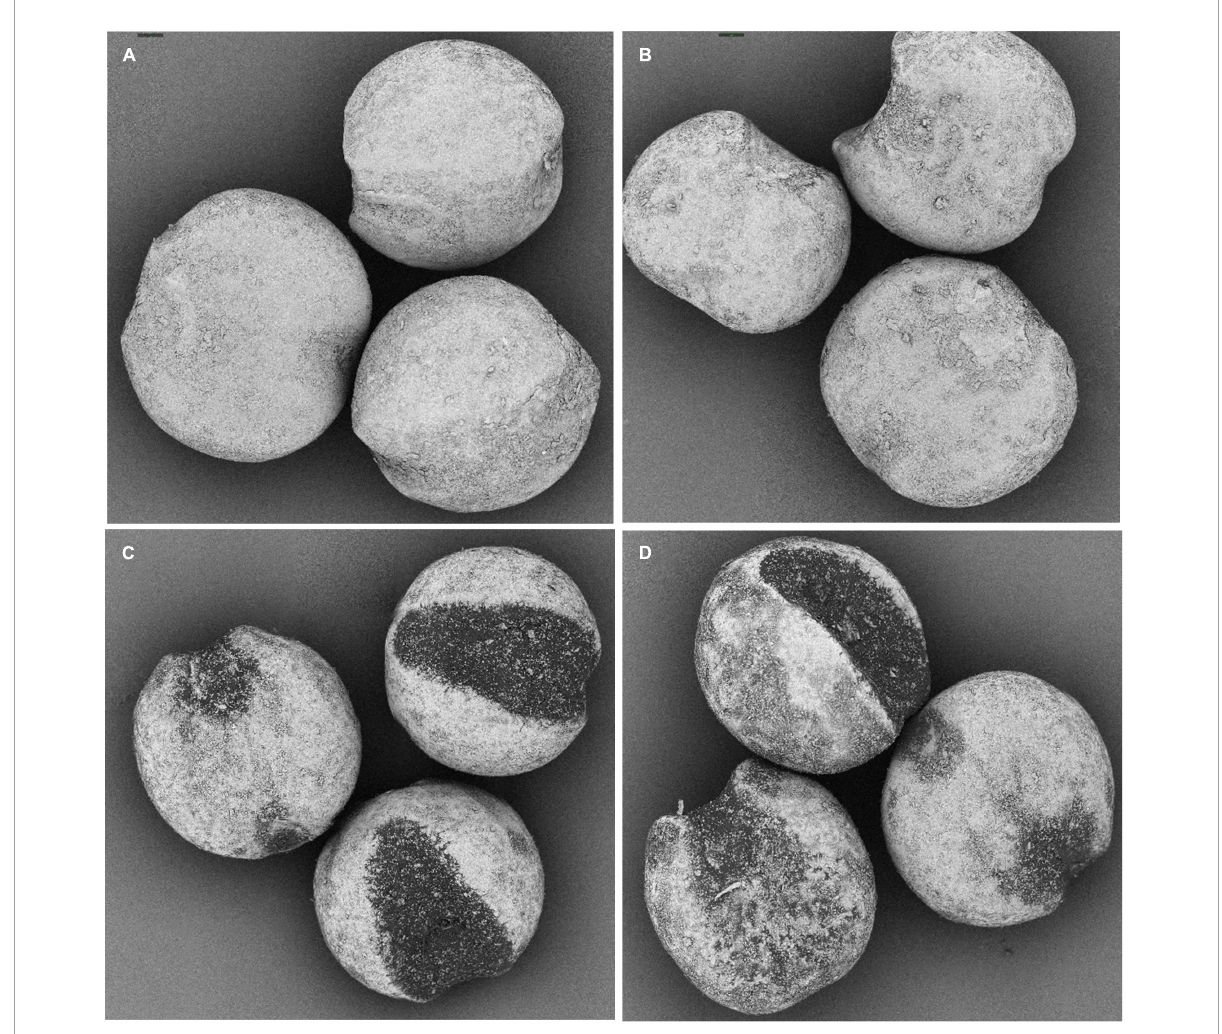
FIGURE5 Morphological images of untreated foxtail millet, (A) Mizhi and (C) Ansai, and after being treated by DBD-ACP at 35 kV for 12 min, (B) Mizhi, (D) Ansai.